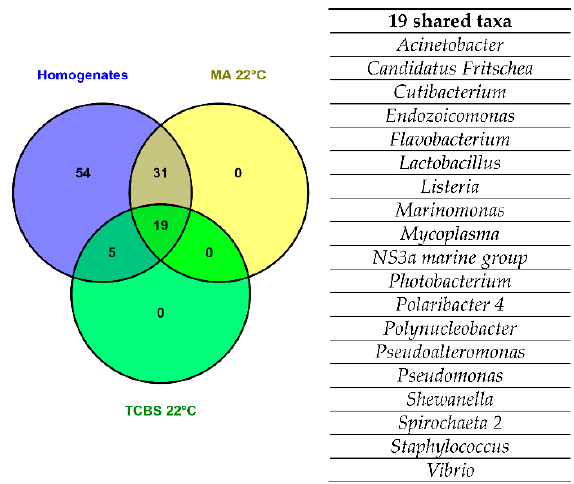
Figure 3. Venn diagram showing the number of taxa, identified by 16S metabarcoding at the ge ‐ nus level, shared among homogenate samples and clam samples plated on MA 22 °C and TCBS 22 °C media. The table report the detail of the nineteen taxa shared among homogenate and plated clam samples. MA 22 °C: clam samples plated on marine agar and incubated at 22 °C; TCBS 22 °C: clam samples plated on Thiosulfate ‐ citrate ‐ bile salts ‐ sucrose agar and incubated at 22